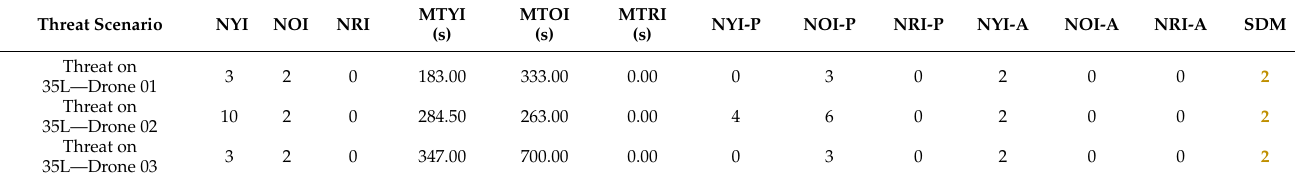
Table A2. Simulation results: safety metrics of solution scenarios. The following colors are used for SDM values: red for catastrophic (4) value; orange for hazardous (3) value; yellow for major (2) value; green for minor (1) value. Bolds values respectively represent the mean and the standard deviation of SDM